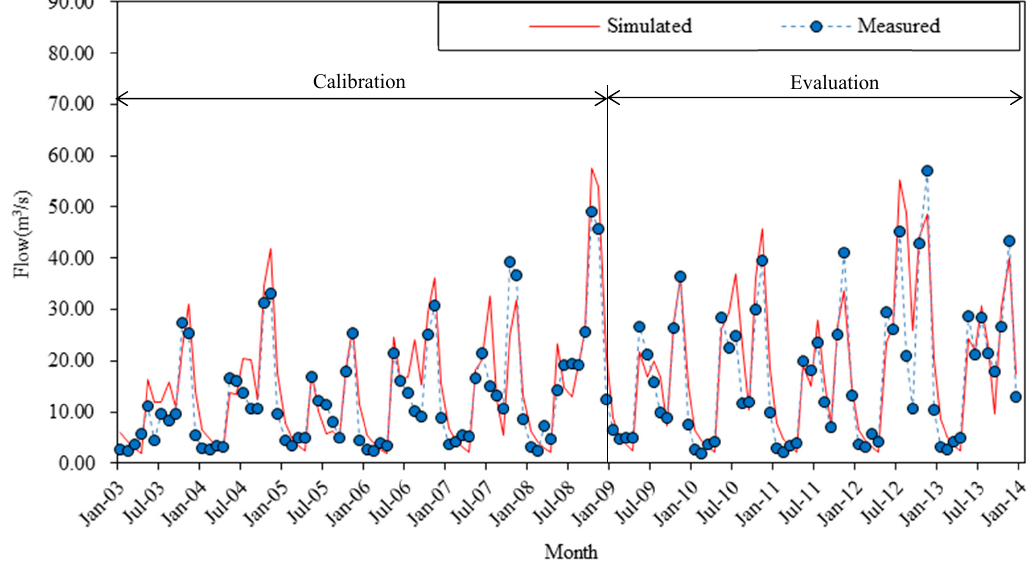
Figure 2. Simulated and measured streamflow at the outlet of the Honggebu Pumping Station. Table 2. Model performance statistics of the simulated and measured monthly streamflow, total nitrogen and total phosphorus at Honggebo pumping